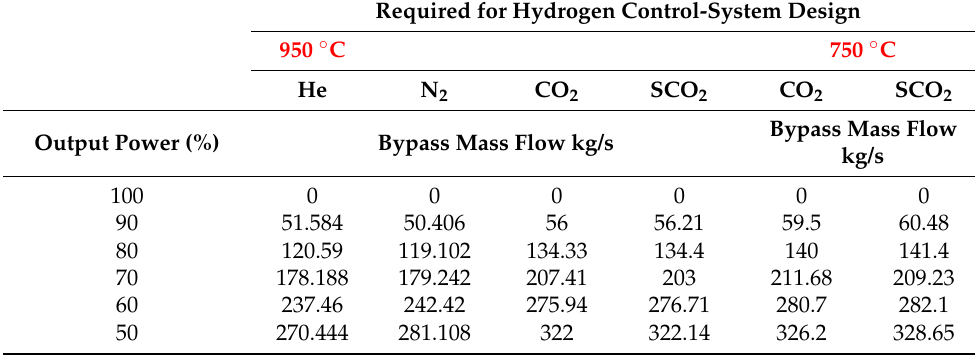
Table 1. Hydrogen-valve offtake mass-flow rates (kg/s).